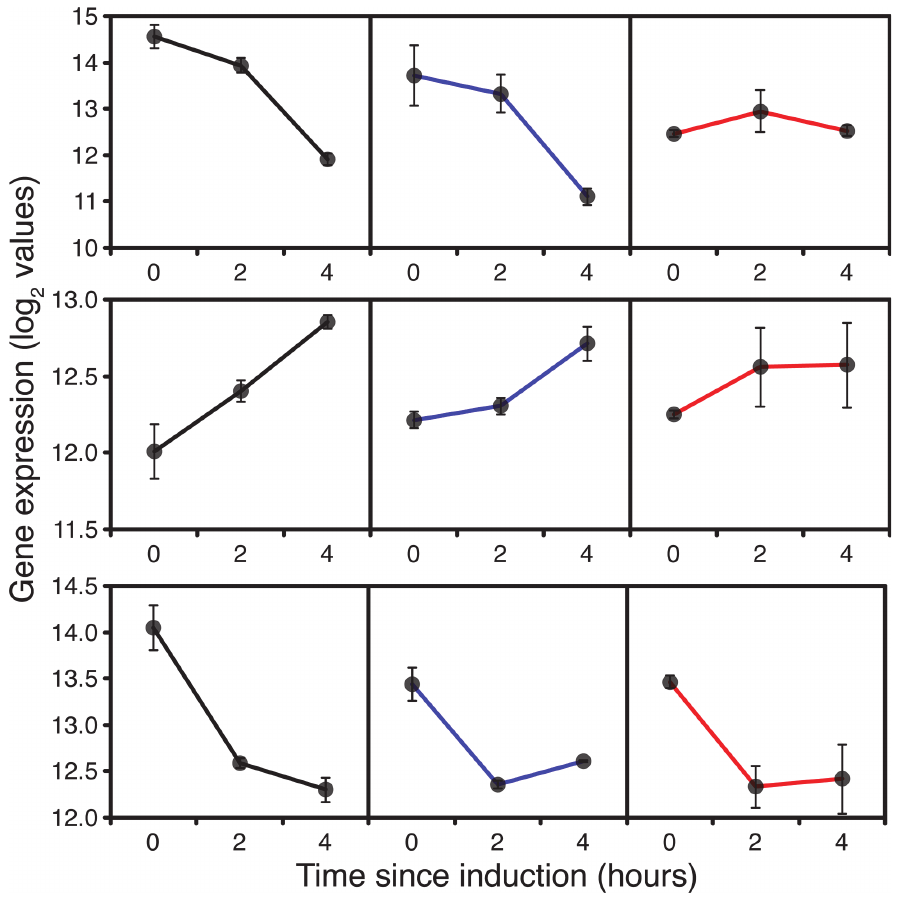
Fig 3. Expression of PCK1 , PYC and PYK during fed-batch culture, 0 (before), 2 and 4 hours after the start of methanol addition to wild-type GS115 (black), TRY1 -1 (blue) and TRY1 -3 (red). Error bars show